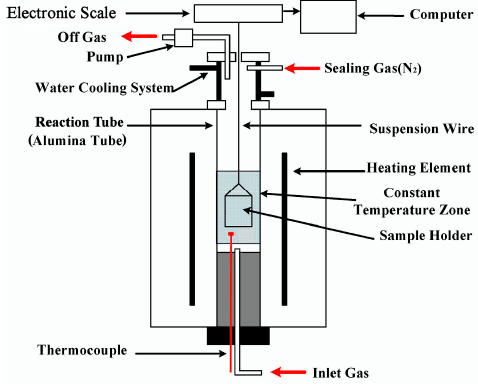
Figure 1. Schematic diagram of the experimental setup.